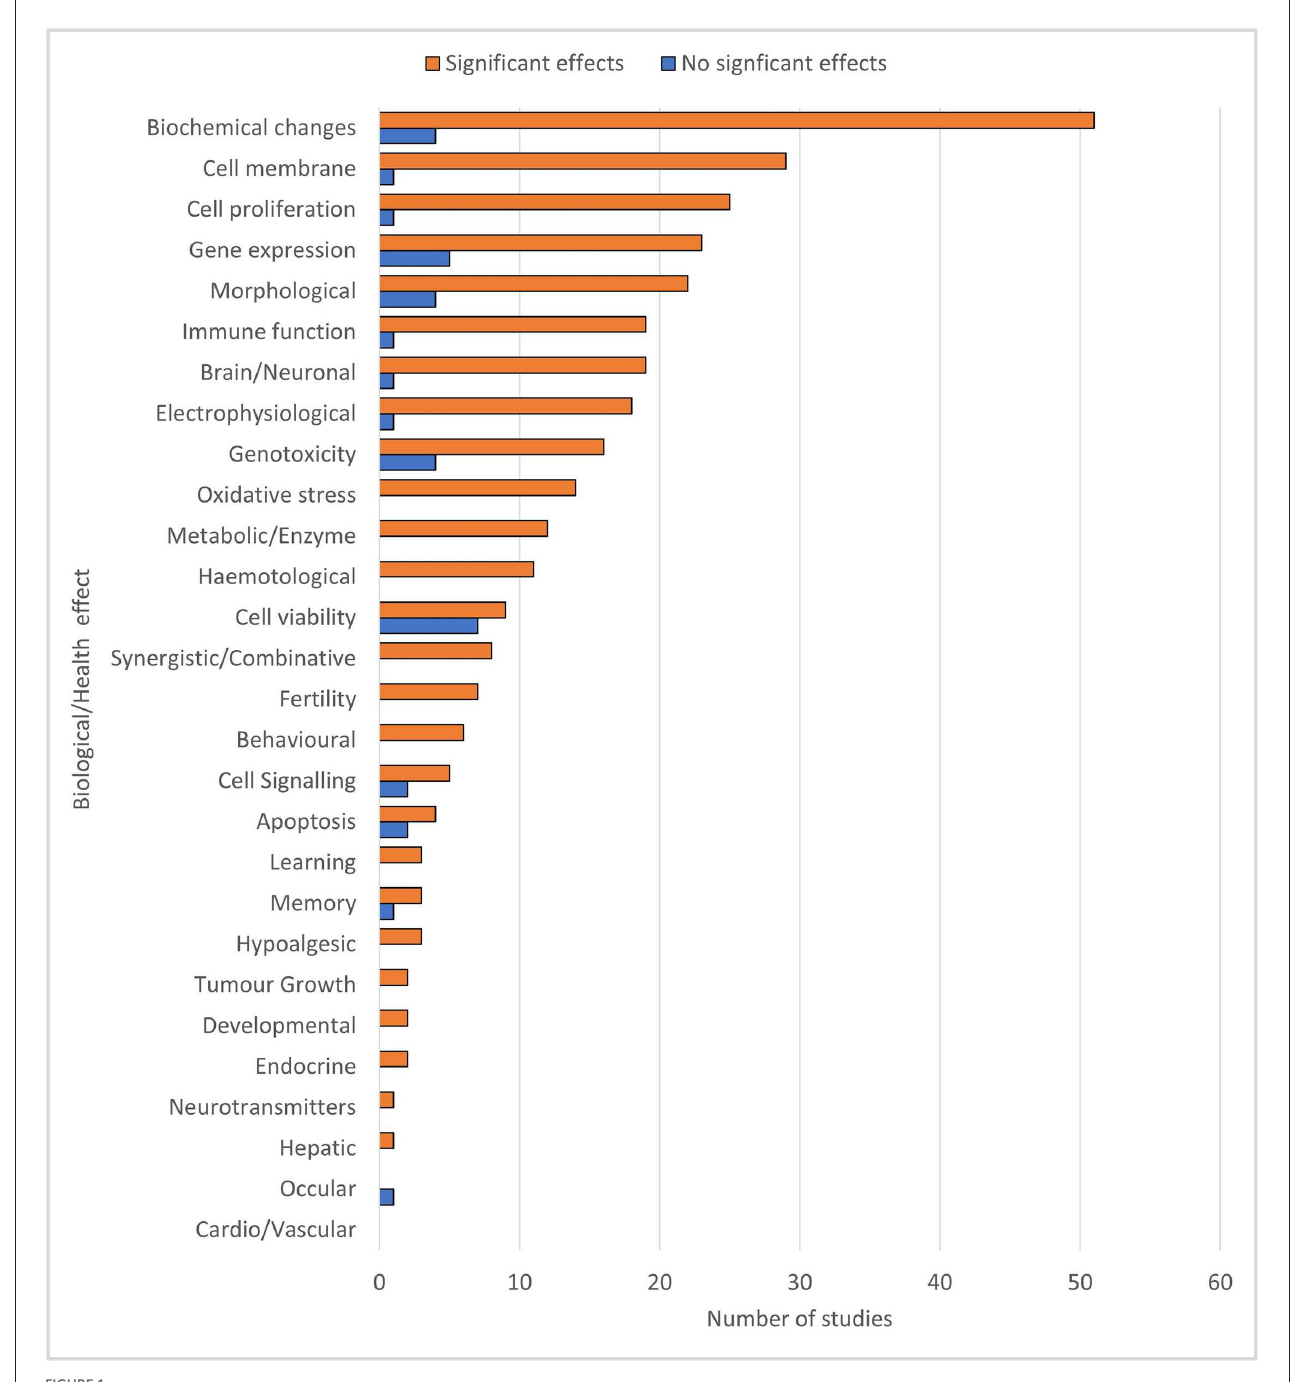
FIGURE1 The main biological and health categories present in the mmWave experimental (i.e., in vitro and in vivo ) literature base, and within each category, the number of papers producing effects vs. the number of papers resulting in no significant effects. The total number of studies is greater than the total number of papers because any given paper may have conducted more than one study and investigated more than one biological